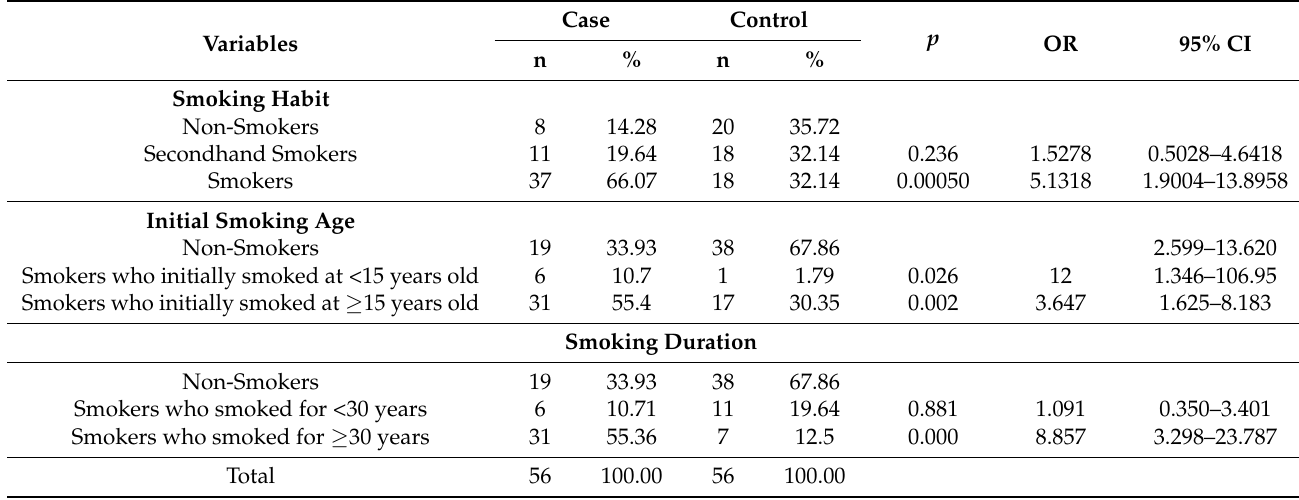
Table 2. Smoking Behavior of